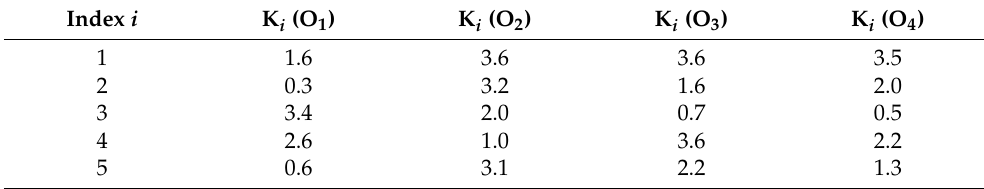
Table 1. Fitting parameters K i for each error term and polarimeter output.